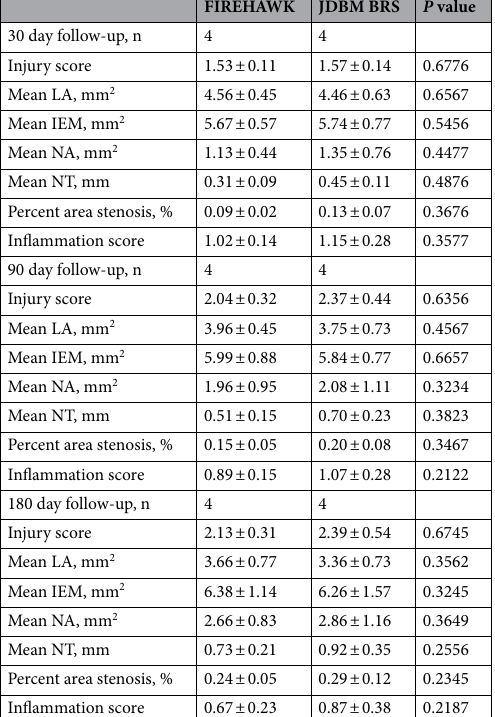
Table 3. Morphometry comparisons. Values are expressed as mean ± SD. LA: average lumen area; IEM: average internal elastic membrane area; NA: average neointimal area; NT: average neointimal thickness; n: number of